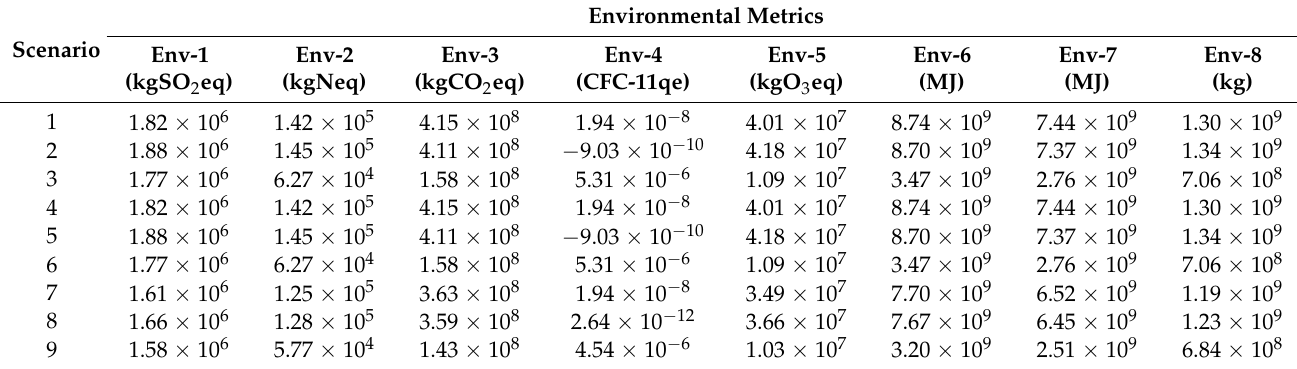
Table 5. Environmental impact analysis results for stages B2 to